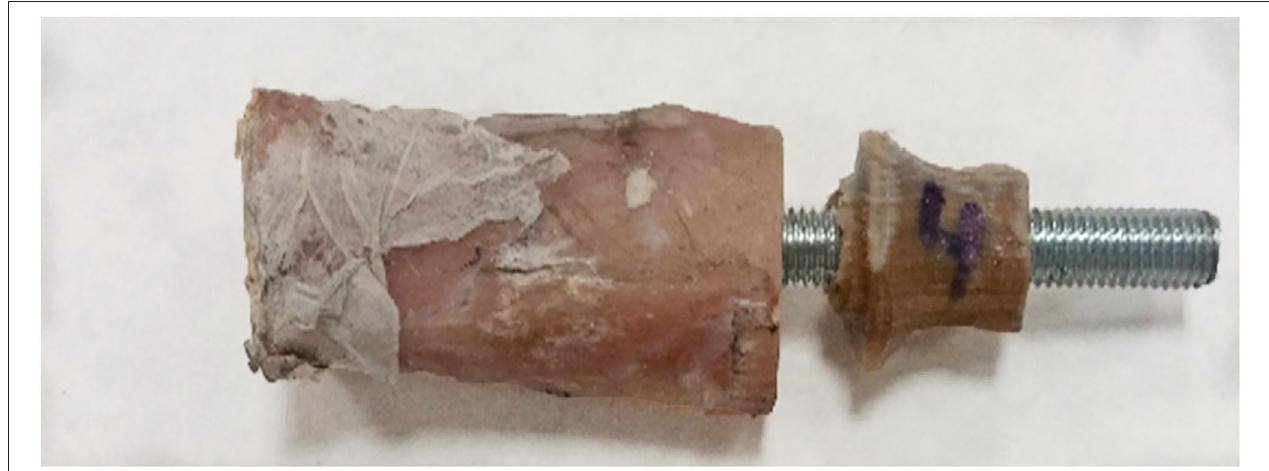
FIGURE 8 | Failure example of the tibia-endoprosthesis constructs observed after pure compression